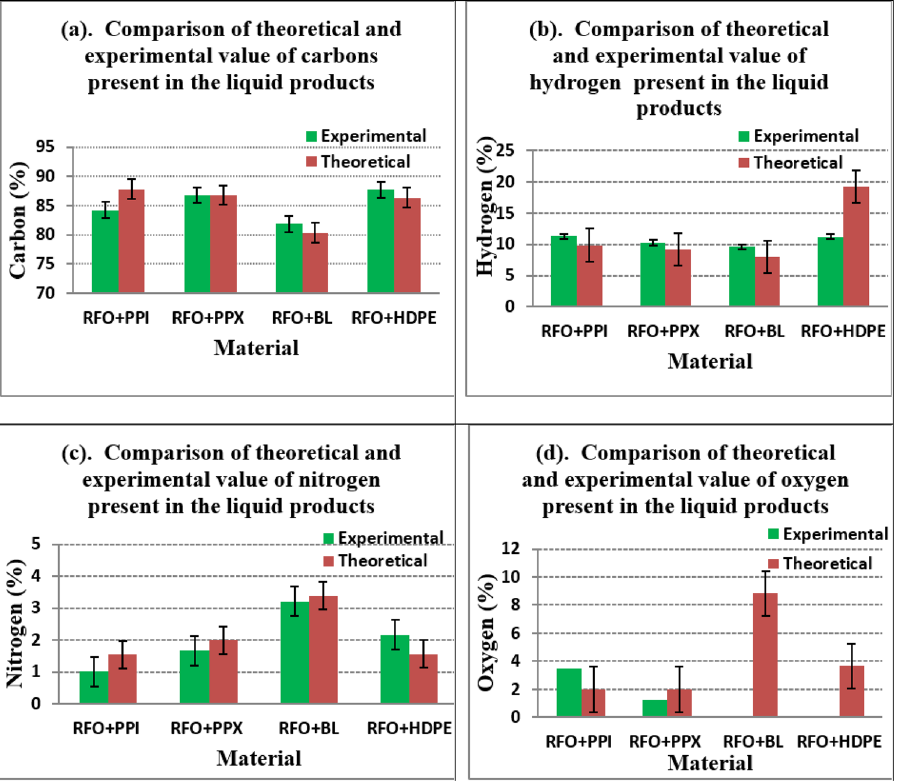
Figure 4. Comparison of theoretical and experimental values ( a ) Carbon ( b ) Hydrogen ( c ) Nitrogen ( d ) Oxygen.